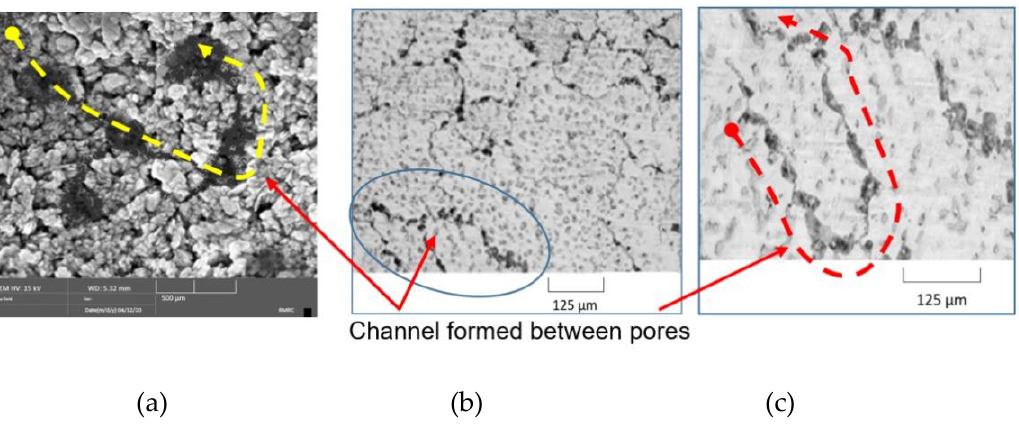
Figure 1. Structure of materials: ( а ) granular concrete; ( b ), ( с ) cellular concrete.